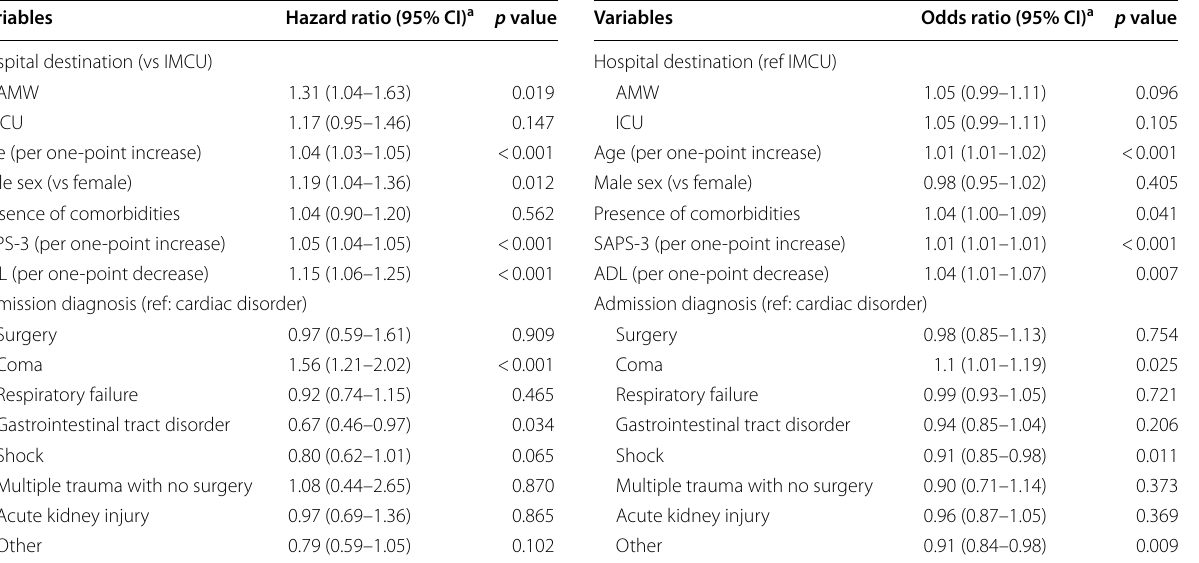
Table 2 Factors associated with 6-month overall survival— multivariate analysis